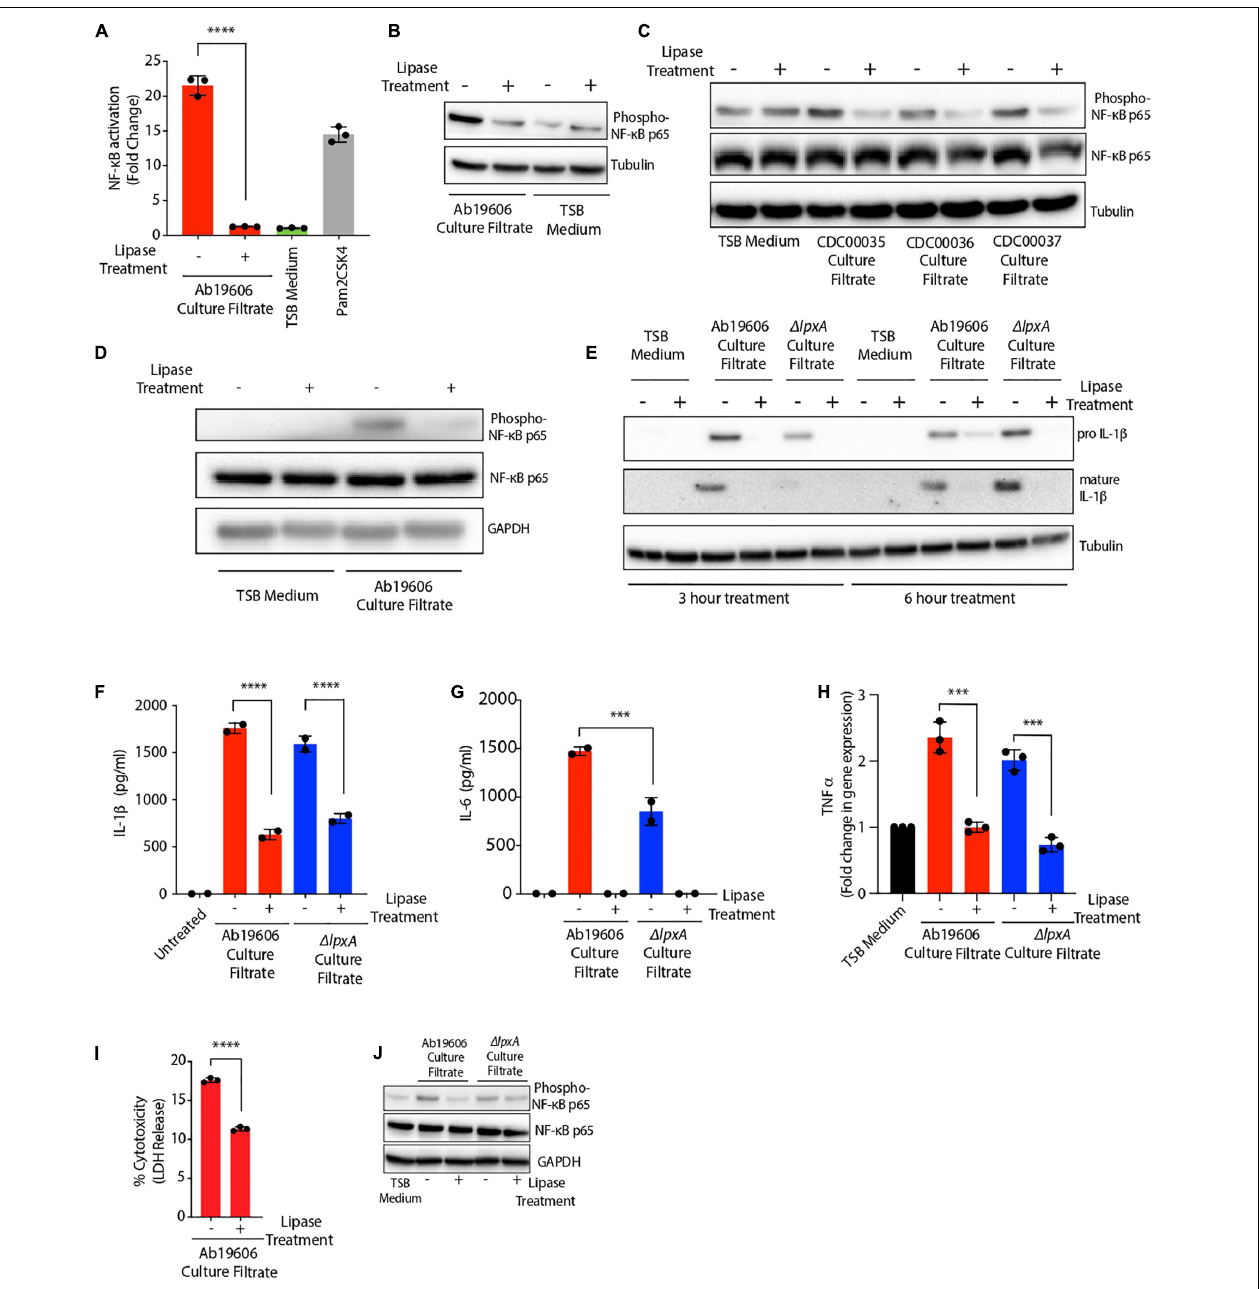
FIGURE 4 | Acinetobacter baumannii secretes a bioactive lipid that triggers immune signaling. (A) Culture filtrate from wildtype A. baumannii (Ab19606) was treated with lipase enzyme overnight. THP1-XBlue reporter cells were exposed to untreated and the lipase treated culture filtrate. Levels of SEAP were assessed after 24 h of culture filtrate treatment. The experiments were done in triplicates. TSB medium was used to grow the bacterial cultures and fresh TSB medium treatment served as the negative control while Pam2CSK4 served as the positive control. Error bars represent standard deviation. One-way ANOVA with Tukey’s multiple comparisons test. (B–D) THP1 macrophages (B,C) and RAW264.7 macrophages (D) were exposed to untreated or lipase treated culture filtrates from the indicated bacteria. Western blot was performed to check the phosphorylation of NF- κ B p65. (E) THP1 macrophages were exposed to untreated or lipase treated culture filtrates from the indicated bacteria for 3 and 6 h. Western blot was performed to check the levels of pro and mature forms of IL-1ß protein. (F–H) THP1 macrophages were exposed to untreated or lipase treated culture filtrate. Levels of secreted IL-1ß (F) , and IL-6 (G) were assessed after 24 h of culture filtrate treatment and gene